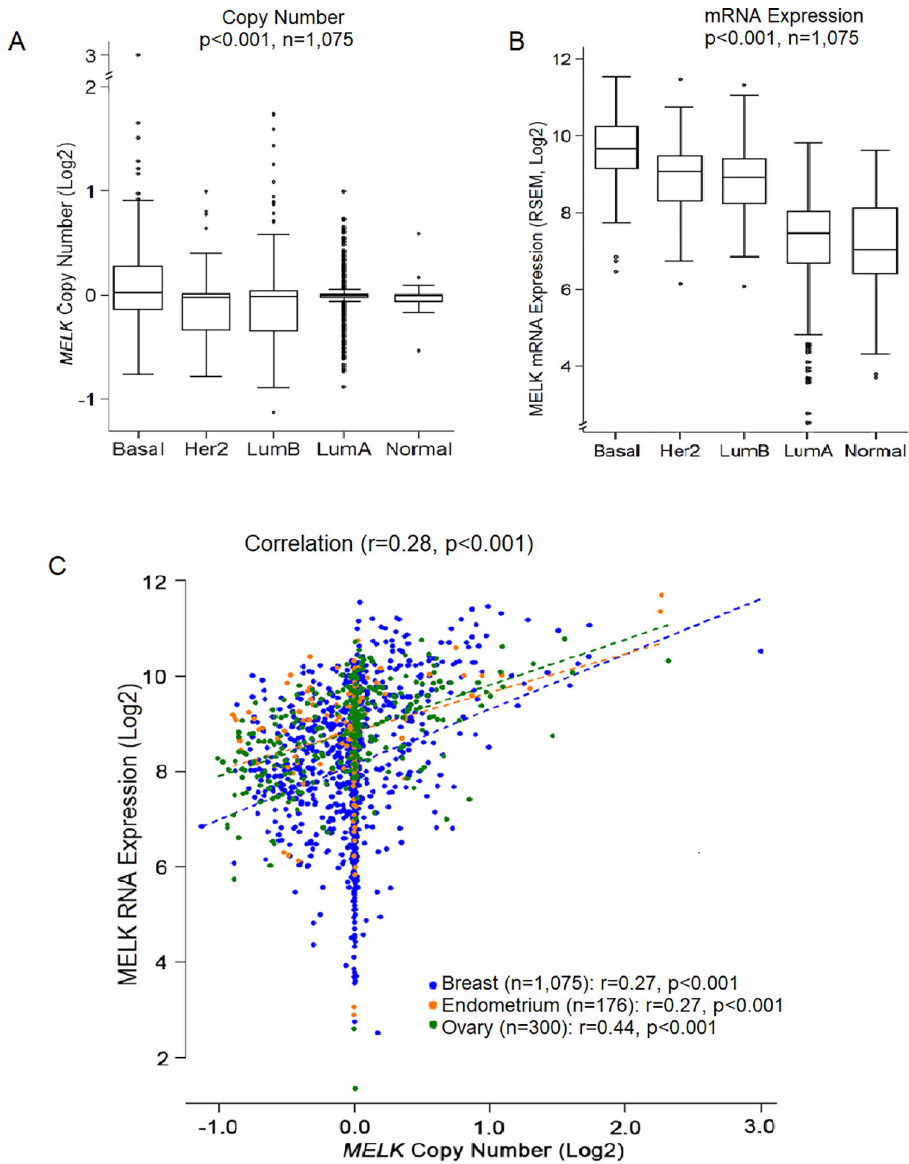
Fig 3. Correlation between MELK gene copies and mRNA expression in breast tumors. (A) Analysis of TCGA CNA dataset (Affymetrix SNP Array 6.0) showed that alterations in MELK DNA CN is significantly correlated with breast cancer subtypes (n = 1,075, p < 0.001), with the highest CN gains in basal-like breast cancer compared to other subtypes of breast cancer (basal vs other subtypes, p < 0.001). (B) MELK mRNA expression is strongly correlated with breast cancer subtypes (n = 1,075, p < 0.001), with the highest expression in basal-like tumors (basal vs other subtypes, p < 0.001). (C) MELK mRNA expression showed a significant correlation with MELK DNA CN in primary breast, endometrial, and ovarian cancers from TCGA datasets (n = 1,551, p < 0.001). The X-axis represents log2 CN and the Y- axis represents log2 RNA transcripts. P -values were calculated using Pearson correlation analysis. normal pattern of two copies of each signal with a MELK : CEP9 (centromere enumeration probe for chromosome 9) ratio of 1.0 (S1 Fig in S1 File). However, breast cancer cells displayed frequent abnormal signal patterns including low to high chromosome polysomy (Table 1 and S2 Fig in S1 File). In particular, many basal-like cell lines were highly polysomic for chromo- some 9 and MELK , compared to luminal subtype cells (Fig 4B and S3 Fig in S1 File). CN gains